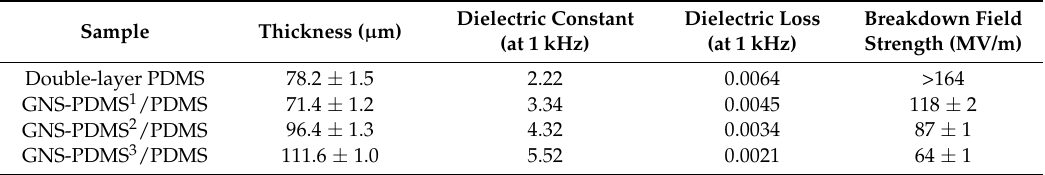
Table 1. Thickness, dielectric constant, dielectric loss, and breakdown field strength of the films. Sample Dielectric Constant Thickness ( µ m) (at 1 kHz)